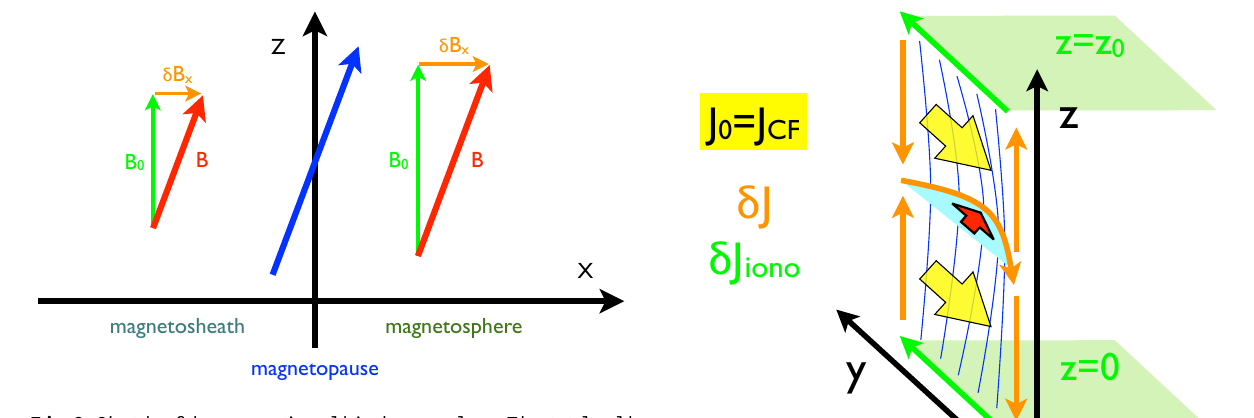
Fig. 6. Sketch of the magnetic field in the x-z-plane: The total field is tangential to the magnetopause on both sides, such that the normal component vanishes. The magnetopause keeps being a tangential discontinuity. The inclination of the magnetic fields corresponds with the local inclination of the magnetopause.